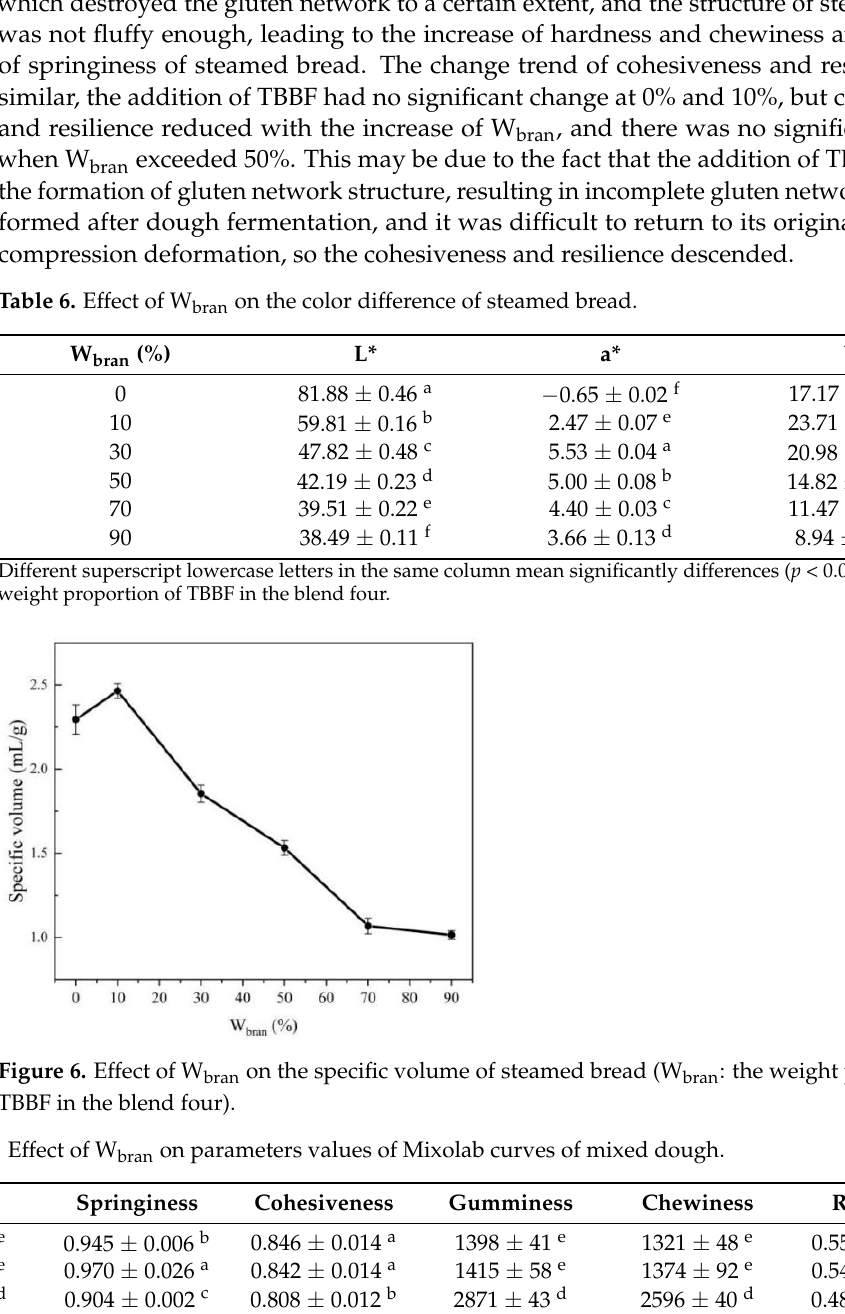
Table 6. Parameters values of Mixolab curves of all samples.